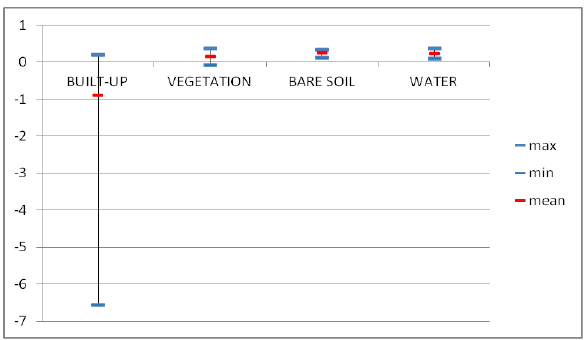
Table 2. Mean and SD values of index for major LULC classes